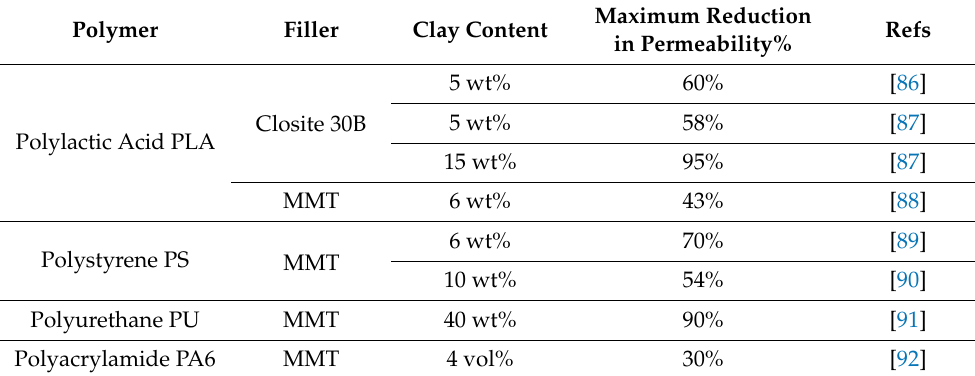
Table 5. Summary studies on water permeability of polymer–clay